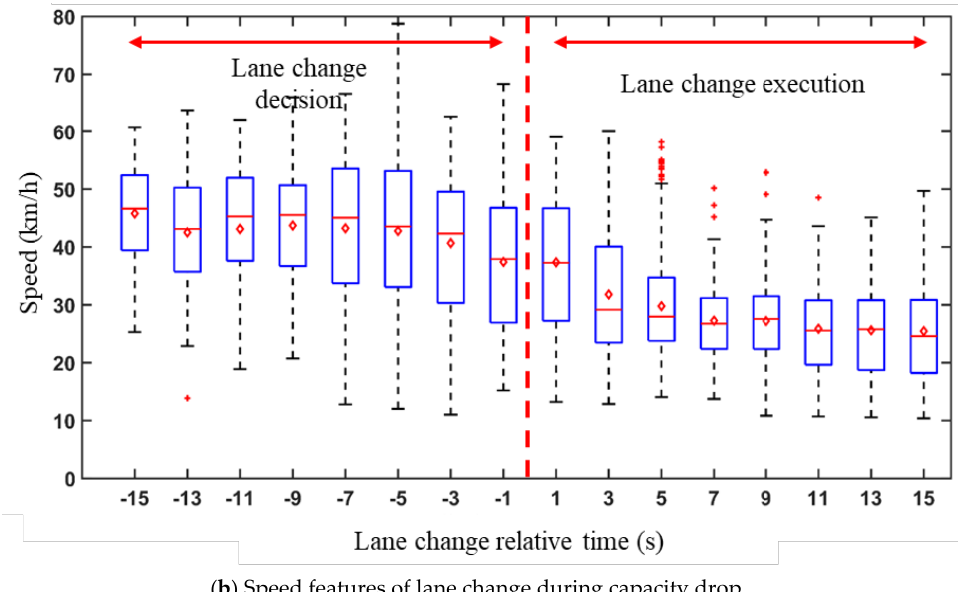
lane-changing vehicles and following vehicles on the target lane, the speed of most vehi- cles is reduced during the lane-changing process. The lane-changing vehicle in the outer